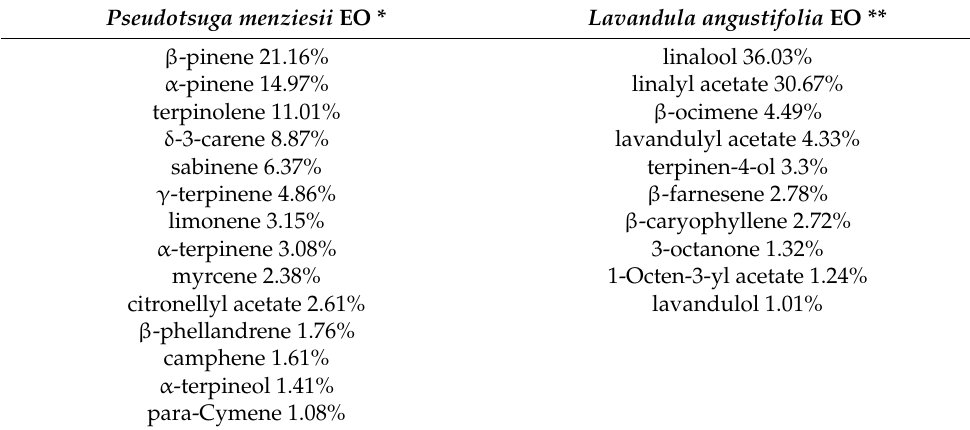
Table 1. Major chemical components of Pseudotsuga menziesii and Lavandula angustifolia essential oils. Pseudotsuga menziesii EO